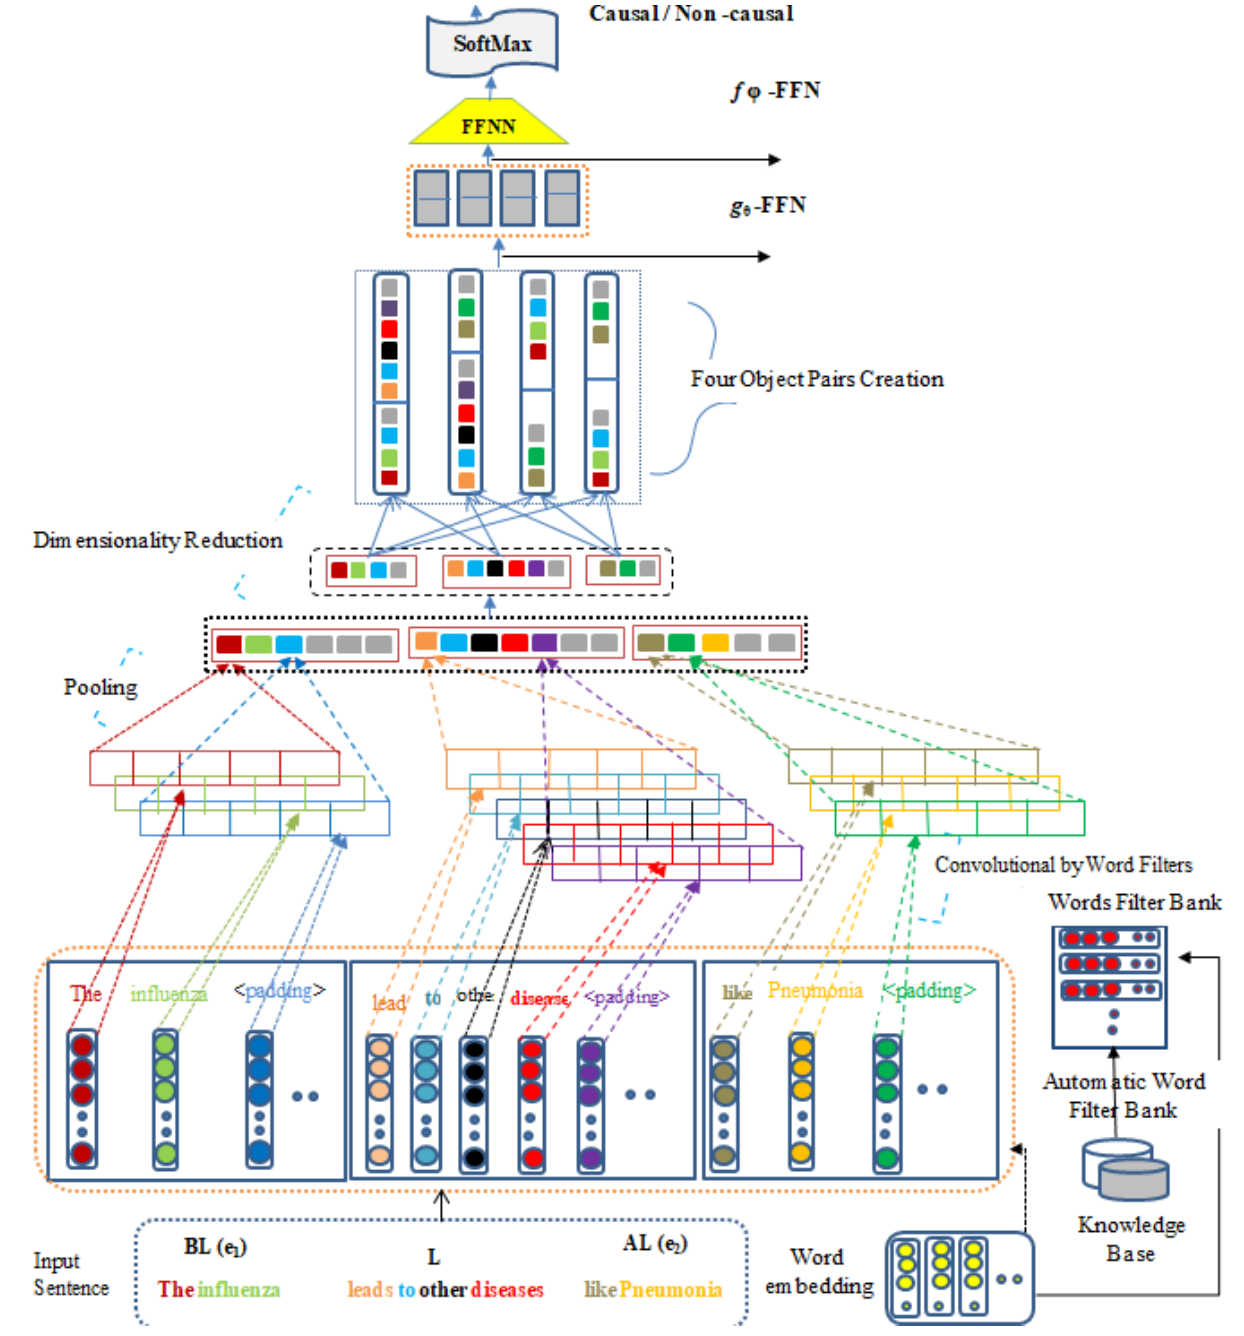
Figure 1. Applied MCKN architecture. This contains three columns using convolutional word filters: the first column processes the BL (e1) part of the input sentence, the second column deals with the L part of the input sentence, and the third column targets the AL (e2) part of the input sentence.